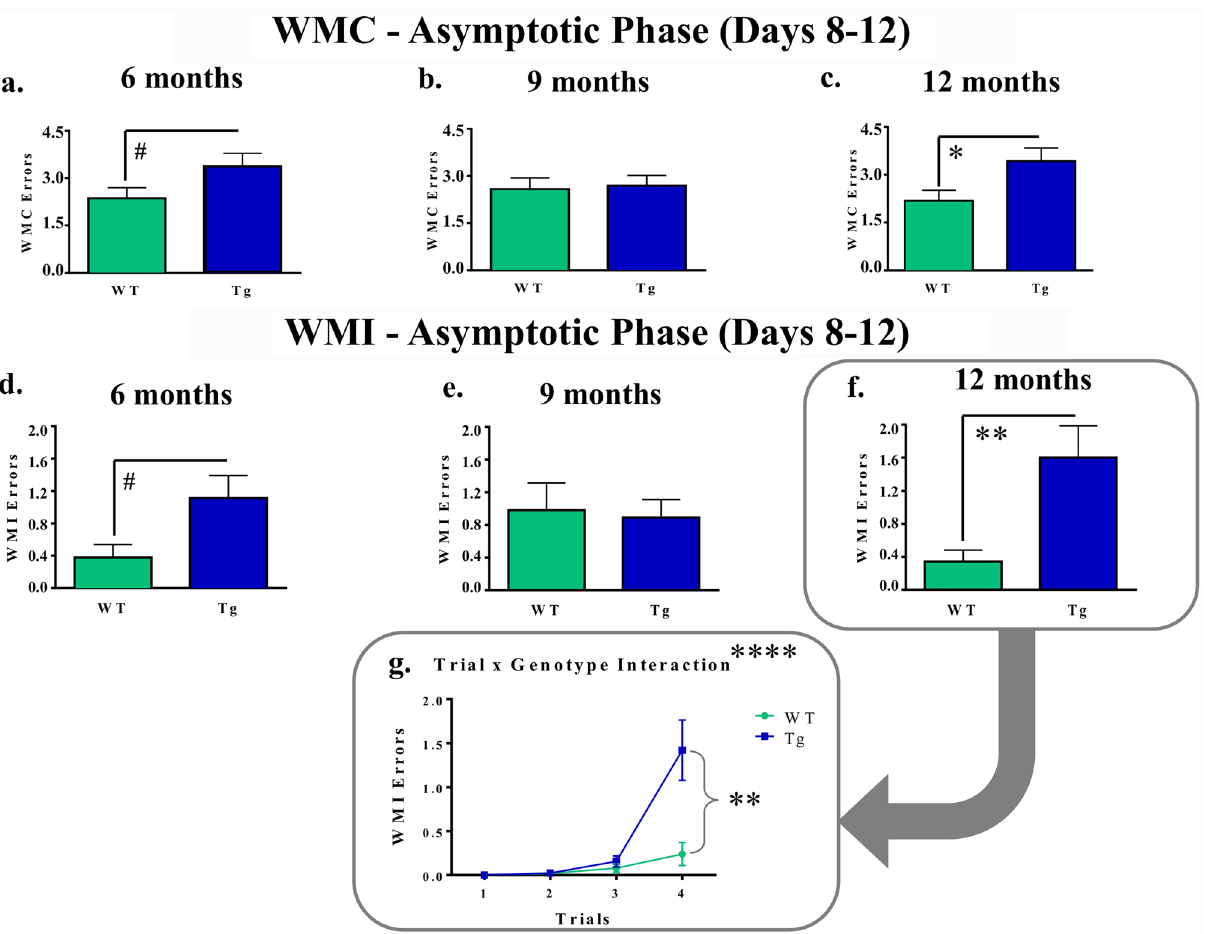
Figure 3. Distinct patterns of working memory deficits in TgF344-AD rats as evaluated on the WRAM. ( a – c ) During the Asymptotic Phase of WRAM testing, 6-month Tg rats made marginally more WMC errors than WT rats. Tg rats at the 12-month timepoint made significantly more WMC errors than WT counterparts, indicating working memory impairment. ( d – f ) Likewise, in the Asymptotic Phase of the WRAM, Tg rats in the 6-month cohort made marginally more WMI errors than WT rats of the same age. At the 12-month timepoint, Tg rats overall made significantly more WMI errors than WT rats. ( g ) Following up on a Trial × Treatment interaction, a genotype effect was found during the highest working memory load trial, with Tg rats making more WMI errors than WT rats at 12-months of age. # p < 0.10, * p < 0.05, ** p < 0.01, **** p < set of planned comparisons [6-month groups: F (1,17) = 7.00, p = 0.0170; 9-month groups: F (1,19) = 11.31, p = 0.0033; 12-month groups: F (1,17) = 7.76, p = 0.0127] (Fig. 6a–c). These collective data indicate a transgenic-induced refer- ence memory impairment, as Tg rats at each age had greater distances and longer latencies to reach the platform than respective WT rats. For each experimental group, when evaluating percent total swim distance in the Target (NE) Quadrant versus the Opposite (SW) Quadrant during the probe trial, there was a main effect of Quadrant [6-month Tg: F (1,8) = 46.98, p = 0.0001; 6-month WT: F (1,9) = 174.68, p < 0.0001; 9-month Tg: F (1,10) = 11.91, p = 0.0062; 9-month WT: F (1,9) = 52.79, p < 0.0001; 12-month Tg: F (1,8) = 9.53, p = 0.0150; 12-month WT: F (1,9) = 45.46, p < 0.0001] (Fig. 5d), where each group swam a greater percent of the total distance in the NE quadrant, where the platform was previously located, compared to the opposite SW quadrant. This indicates that each group spatially localized to the platform by the end of testing. VP. To ensure that subjects had the visual and motor acuity necessary to complete the procedural components of a water escape task, VP data were analyzed for all experimental groups according to our set of planned com- parisons. Across all 6 trials, when evaluating latency to the platform, there was a main effect of Trial for each set of planned comparisons [6-month groups: F (1,17) = 5.85, p = 0.0001; 9-month groups: F (1,19) = 4.98, p = 0.0004; 12-month groups: F (1,17) = 5.28, p = 0.0003] (Supplemental Fig. 2a–c), with latency decreasing across testing trials; there was no effect of Genotype for any of the planned comparisons. For the 12-month groups, there was a sig- nificant Trial × Genotype interaction [ F (5,85) = 2.98, p = 0.0158]. This interaction appeared to be dependent upon Trial 1, where on average, Tg rats had longer swim latencies than their WT counterparts; this is likely due to